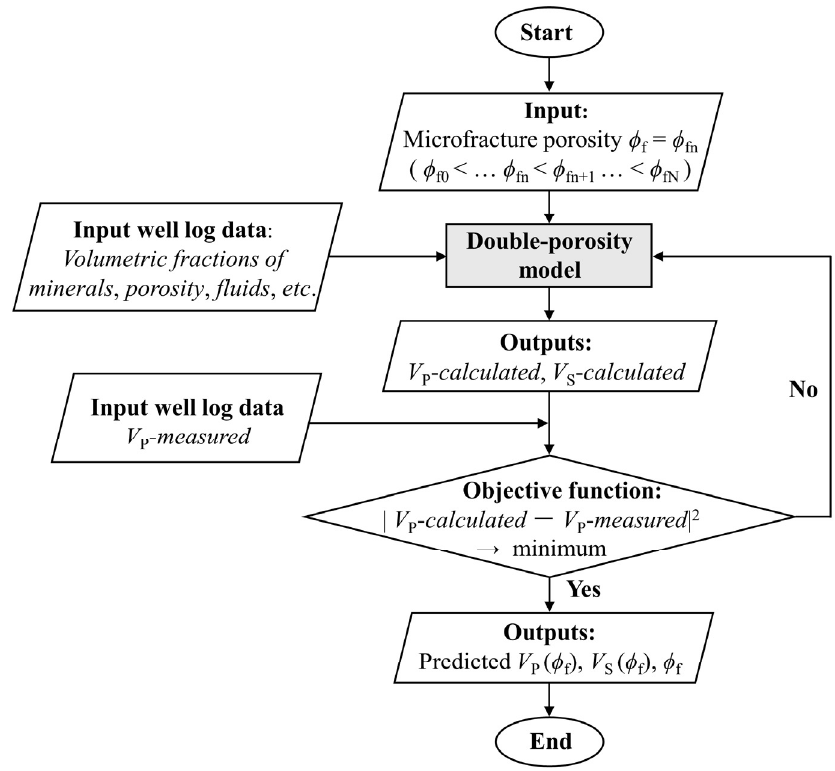
Figure 3. Workflow for predicting microfracture porosity based on the double-porosity model using well-log data.